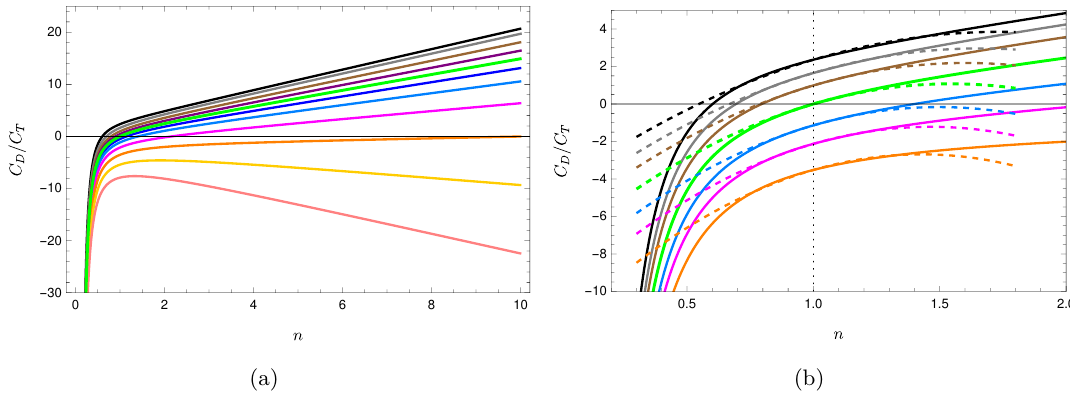
Figure 2 . Plots of C D /C T , defined in eqs. (3.13) and (3.35), as a function of n in d = 4 . The colours correspond to different fixed values of the chemical potential ˜ µ in eq. (3.37) with ‘ (a) The different curves correspond to ˜ µ 2 = ± 0 . 04 , ± 0 . 09 , ± 0 . 16 , ± 0 . 25 , 0 . 36 , 0 . 49 , with ˜ µ 2 increasing from top to bottom. We highlight in green the curve corresponding to ˜ µ = 0 . Note that ˜ µ 2 can be negative, as the chemical potential can take imaginary values. (b) Zoom of the same plot around the region close to n = 1 . The dashed lines correspond to the analytic expansions in eq. (3.42). Curves with the same colours correspond to the same chemical